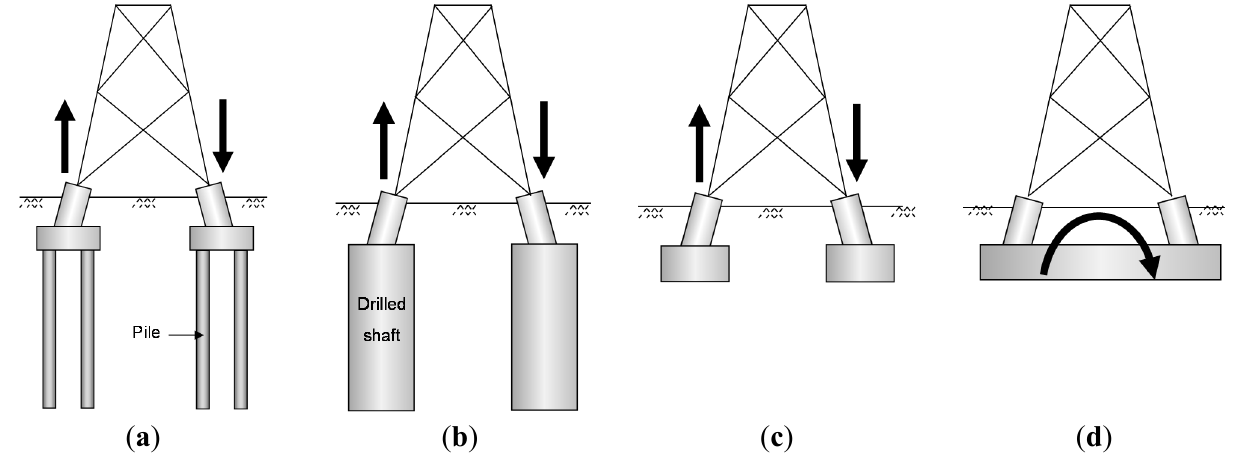
Figure 1. Types of transmission tower foundations: ( a ) pile foundation; ( b ) pier foundation; ( c ) inverted-T foundation; and ( d ) mat